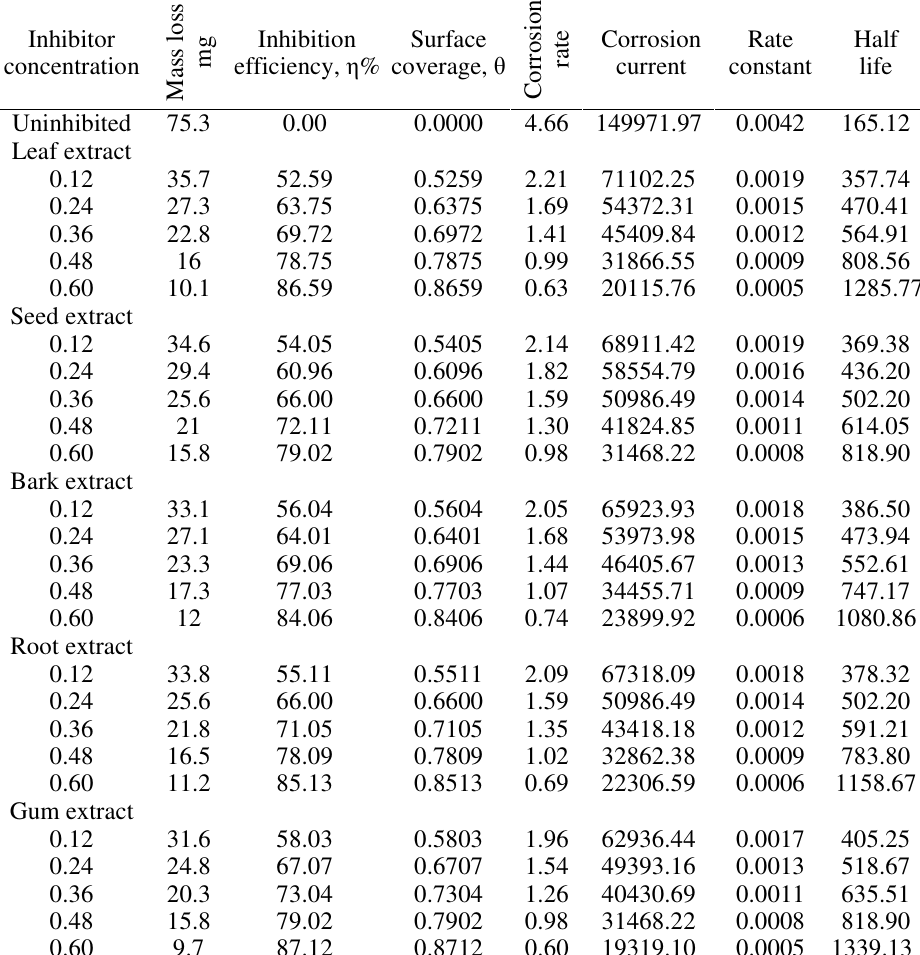
Table 2. Effect of extract of different parts of plants acacia Senegal on mass loss data for corrosion of mild steel in 0.2 N HCl at 298±1K, Effective area of specimen: 7.50 cm 2 Immersion time 24 h